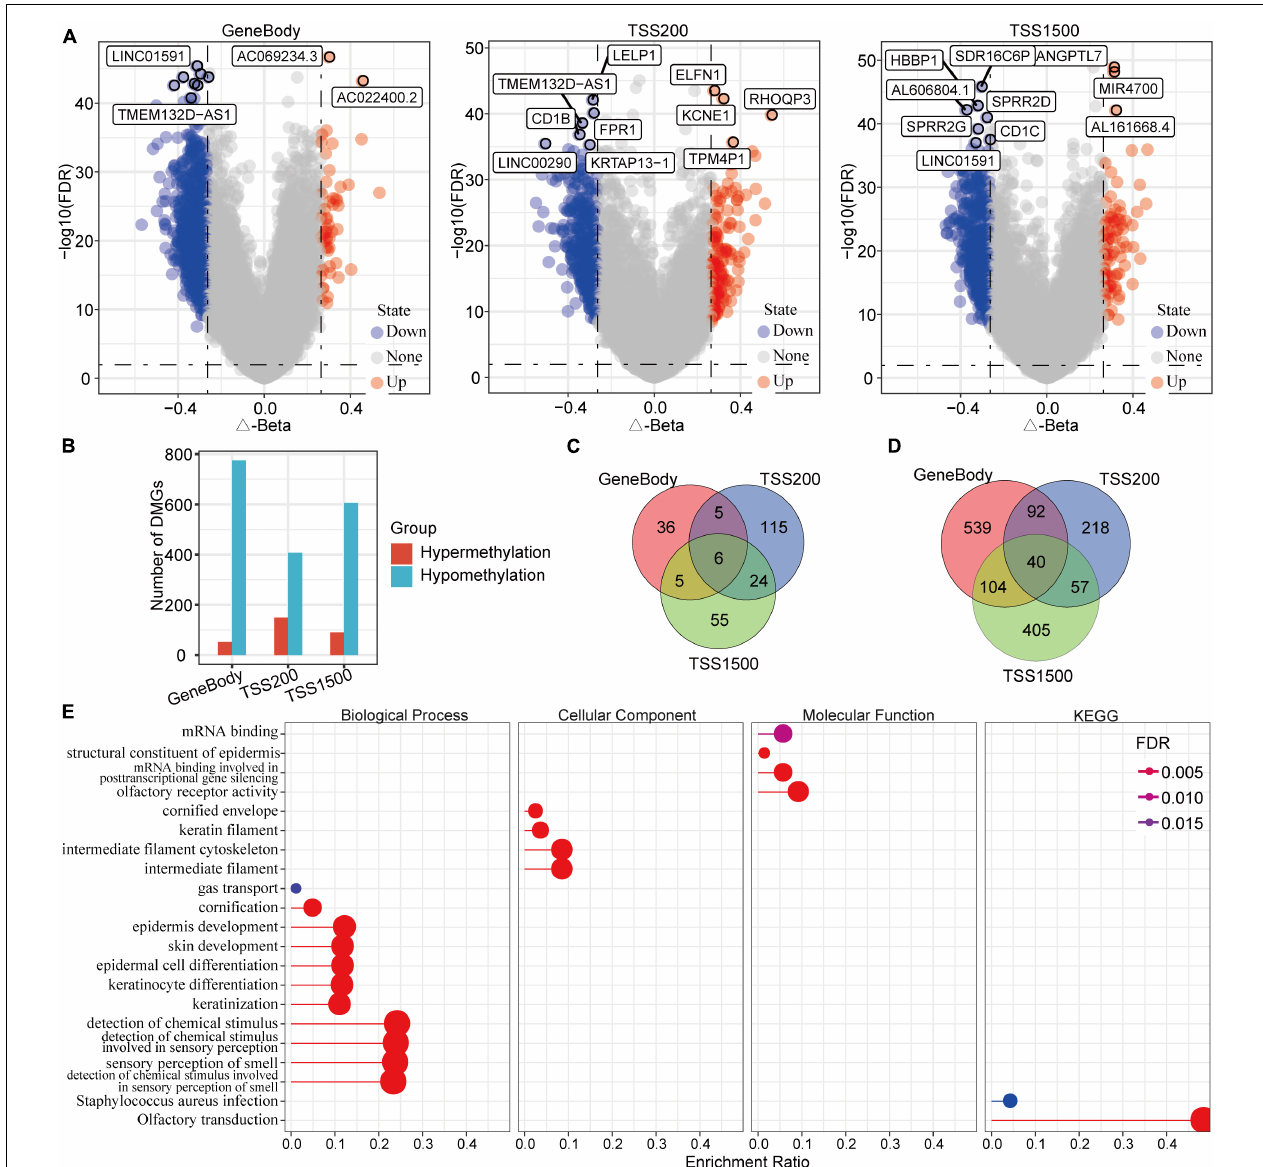
FIGURE 2 | Identification and characteristics of genes with differential DNA methylation in PD-1 negative HCC samples. (A) A volcano map of methylation differences of the gene body, TSS200, and TSS1500 regions in PD-1 negative HCC samples. (B) The differentially methylated genes in these three regions were mostly hypomethylated. (C) A Venn diagram of hypermethylated genes in the three regions. (D) A Venn diagram of hypomethylated genes in the three regions. (E) Gene ontology functional-enrichment analysis and KEGG annotation analysis of differentially methylated genes. The most-intense red color represents the smallest FDR, and dot size is proportional to enrichment